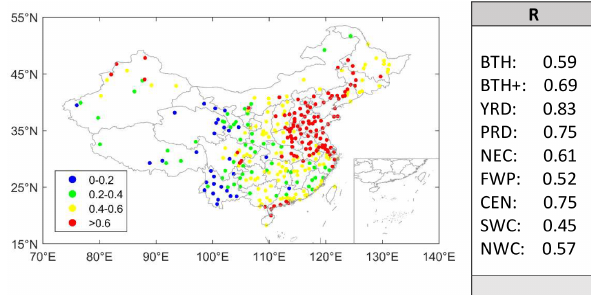
Figure 4. Correlation coefficients ( R ) between the EMI 2 . 5 and the observed PM 2 . 5 daily concentrations across China for 2017 and for typical regions averaged between 2013 and